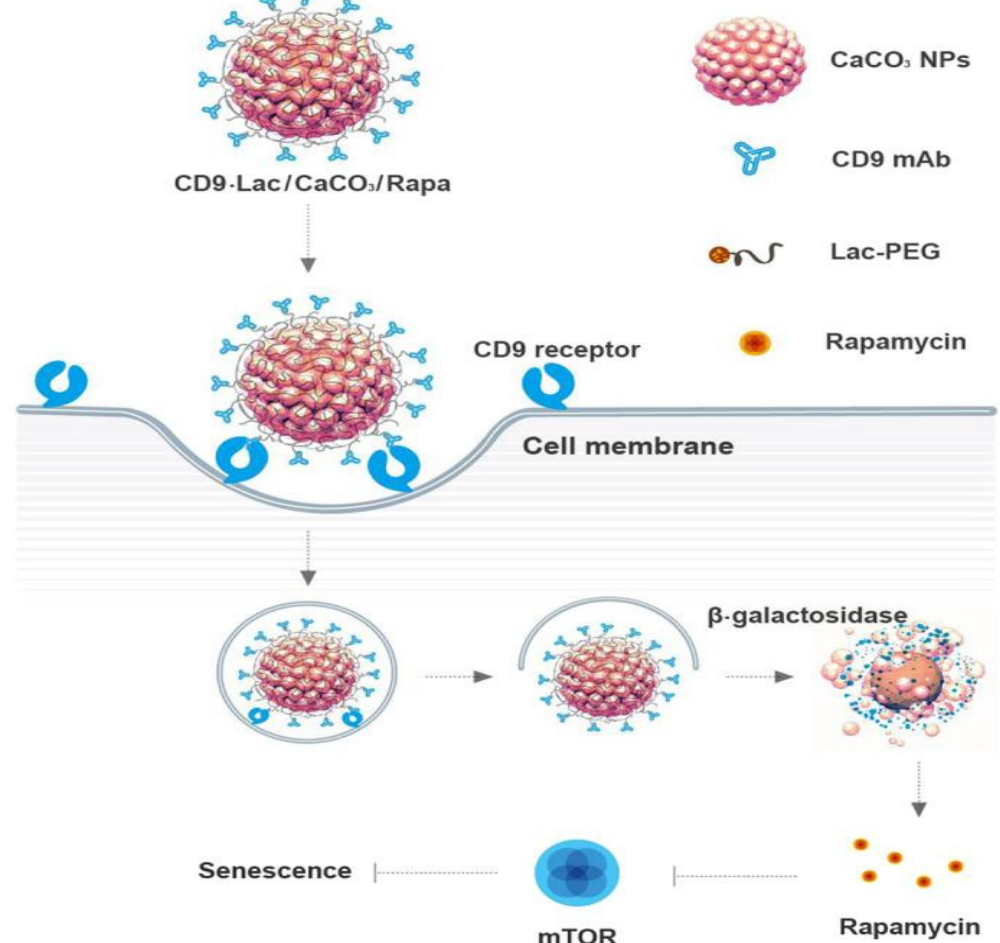
Figure 3. Calcium carbonate (CaCo3) nanoparticles with the tetraspanin CD9, Rapamycin, and lactose. Rapamycin was enabled due to the β galactosidase activity of cleating lactose. Reprinted with permission from [85].